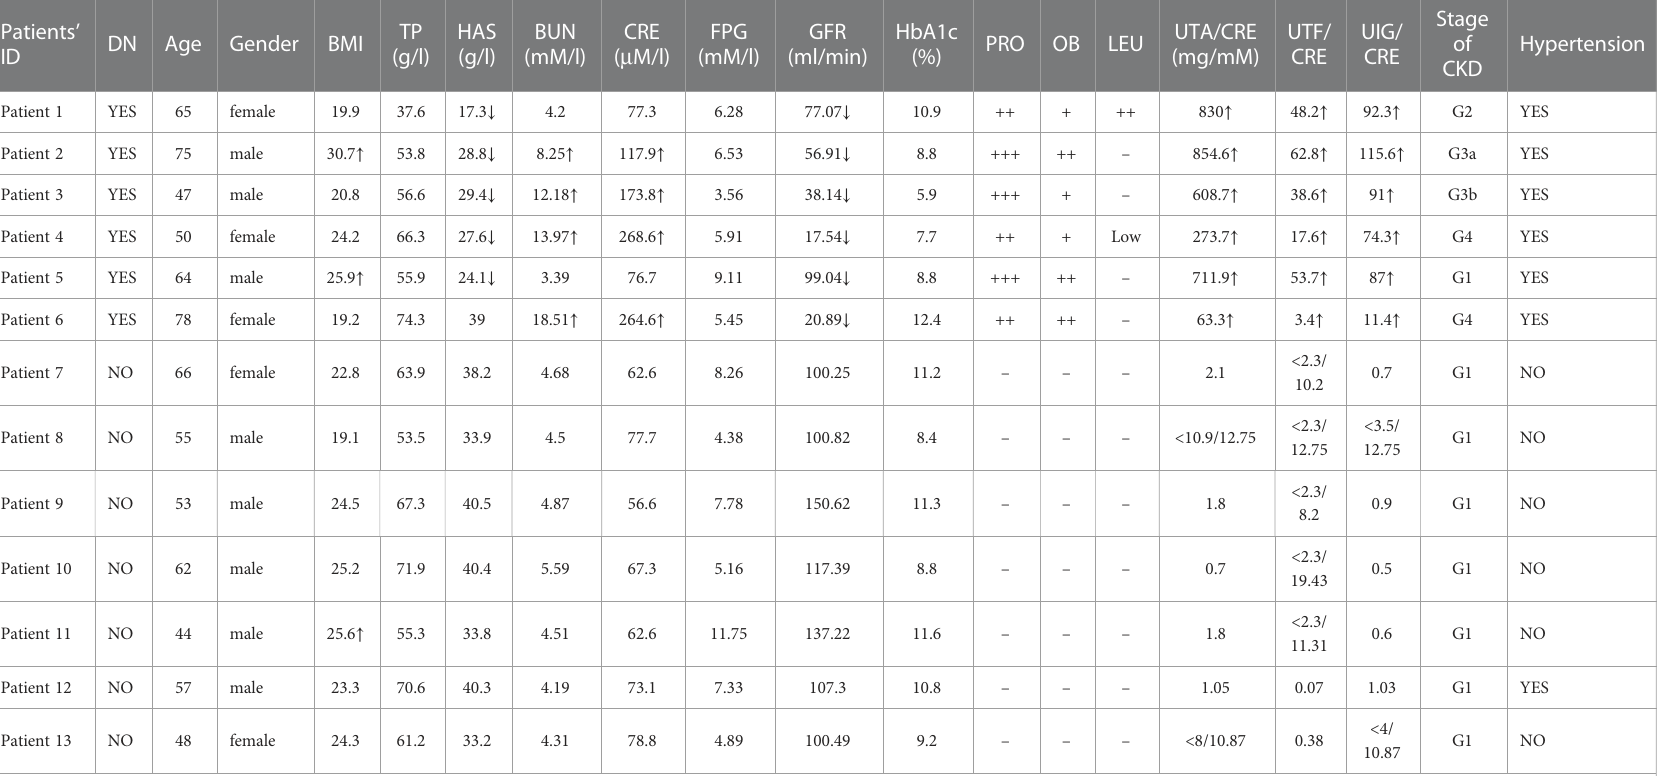
Arrows indicate an increase ( ↑ ) or decrease ( ↓ ) in the T2DM patients with or without DN. DN, diabetic nephropathy; BMI, body mass index; TP, total protein; HAS, albumin; BUN, urea nitrogen; CRE, creatinine; FPG, fasting plasma glucose; GFR, glomerular fi ltration rate; HbA1c, hemoglobin A1C; PRO, urine protein; OB, urine occult